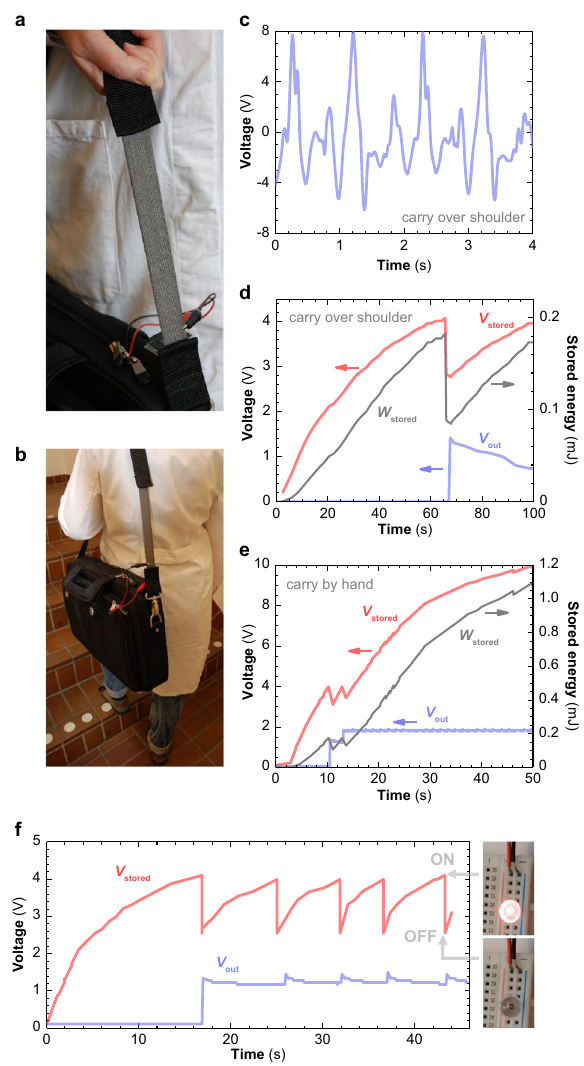
Fig. 5 Energy harvesting with a piezoelectric shoulder strap. a A twill-woven textile band with PA silver conducting yarn as the outer electrode was sewn into the shoulder strap of a laptop case. b Walking up and down stairs with the laptop bag over the shoulder generates c a piezoelectric voltage where the peaks correspond to footfall. d The voltage V stored (red) and energy W stored (grey) stored in an EHC, and the output voltage V out (blue) when carrying the laptop case over the shoulder. An average output power of 1 µW is obtained after an initial charging time of about 1 min ( R load = 1 M Ω ). e V stored (red), W stored (grey) and V out (blue) when holding the laptop case by hand. The piezoelectric textile continuously generates 4 µW after an initial charging time of 15 s. f The load resistor (as in e ) can be replaced with an LED, which then blinks continuously after an initial charging time of about 15 s. The results presented in c – f were produced under wet